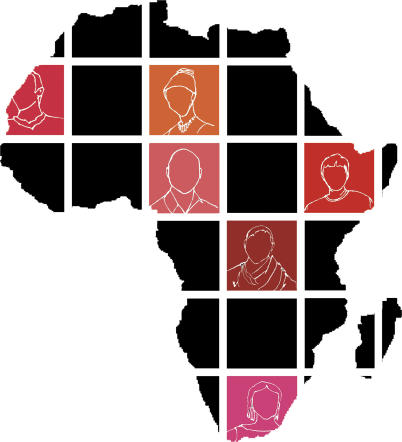
Different approaches to rationing HIV drugs will have different social and economic consequences for African populations(Illustration: Margaret Shear)